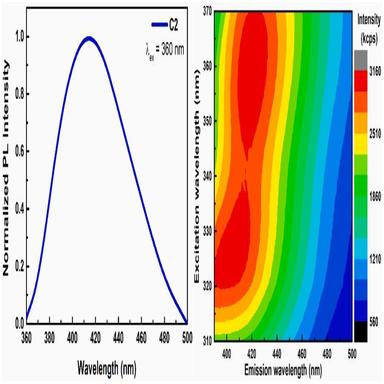
Normalized PL intensity (left) and 3D representation of PL intensity versus excitation and emission wavelengths (right) of C2 thin film.